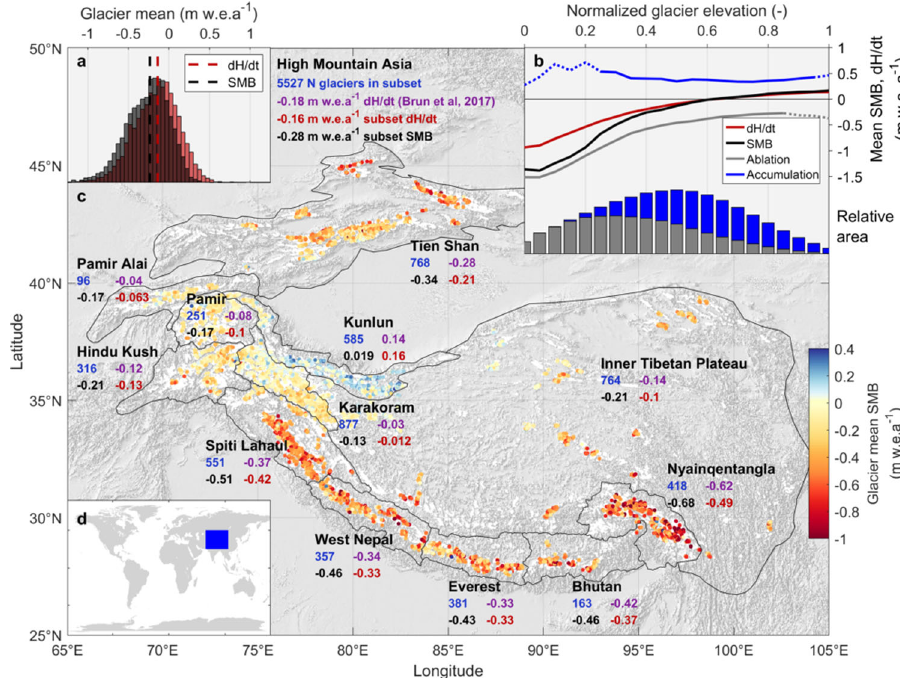
Fig. 1 Summary of the altitudinally resolved speci fi c mass balance (SMB) results of this study. a Mass balance of glaciers in High Mountain Asia based on our speci fi c mass balance results and compared to that derived from elevation change data (d H/ d t ) 15 . b Regional area-weighted mean SMB and d H/ d t for the 2000 – 2016 period, also indicating mean rates of accumulation and ablation, all shown with elevation normalized to each glacier ’ s elevation range. c The spatial pattern of glaciers analyzed and our results for glacier and subregional mass balances (SMB), also compared to the d H/ d t results for each subregion and the glacier subset that we process. Uncertainty and subregional pro fi les are shown in Supplementary Figs. 8, 9. Glaciers we did not process are shown in white, and the background is hillshade of the GTOPO30 dataset sourced from the USGS (https://doi.org/10.5066/F7DF6PQS). d Geographic position of the HMA